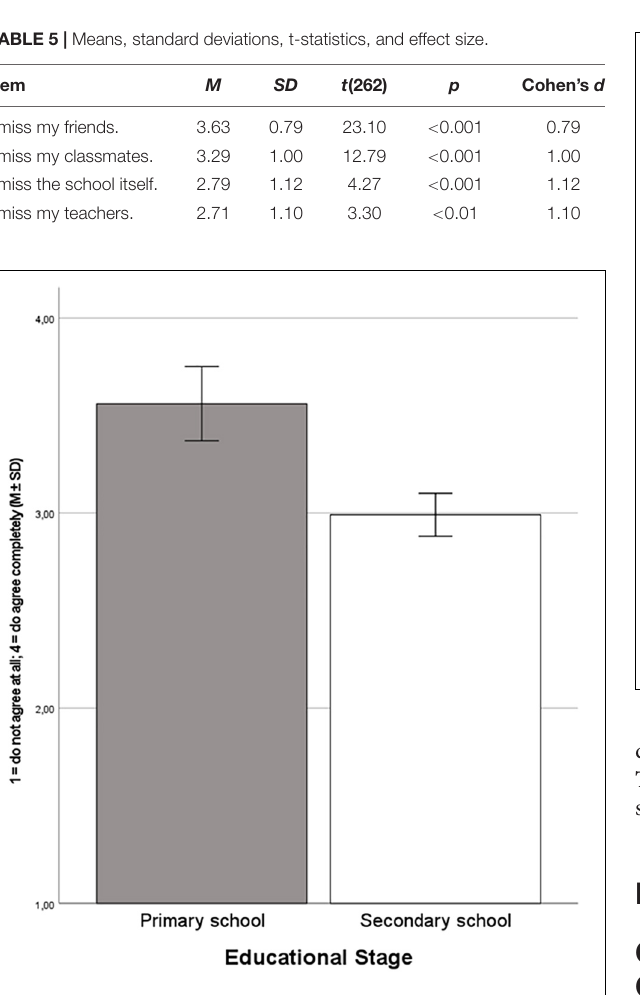
FIGURE 1 | Main effect of educational stage on students’ experiences of social distancing.